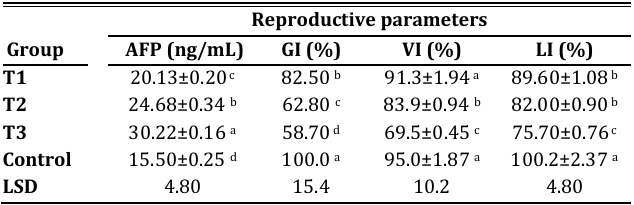
Table 1. Alpha fetoprotein (AFP ng/mL), gestation index (GI%), viability index (VI%), and lactation index (LI%) of Albino Wistar female rats treated orally with 0.7